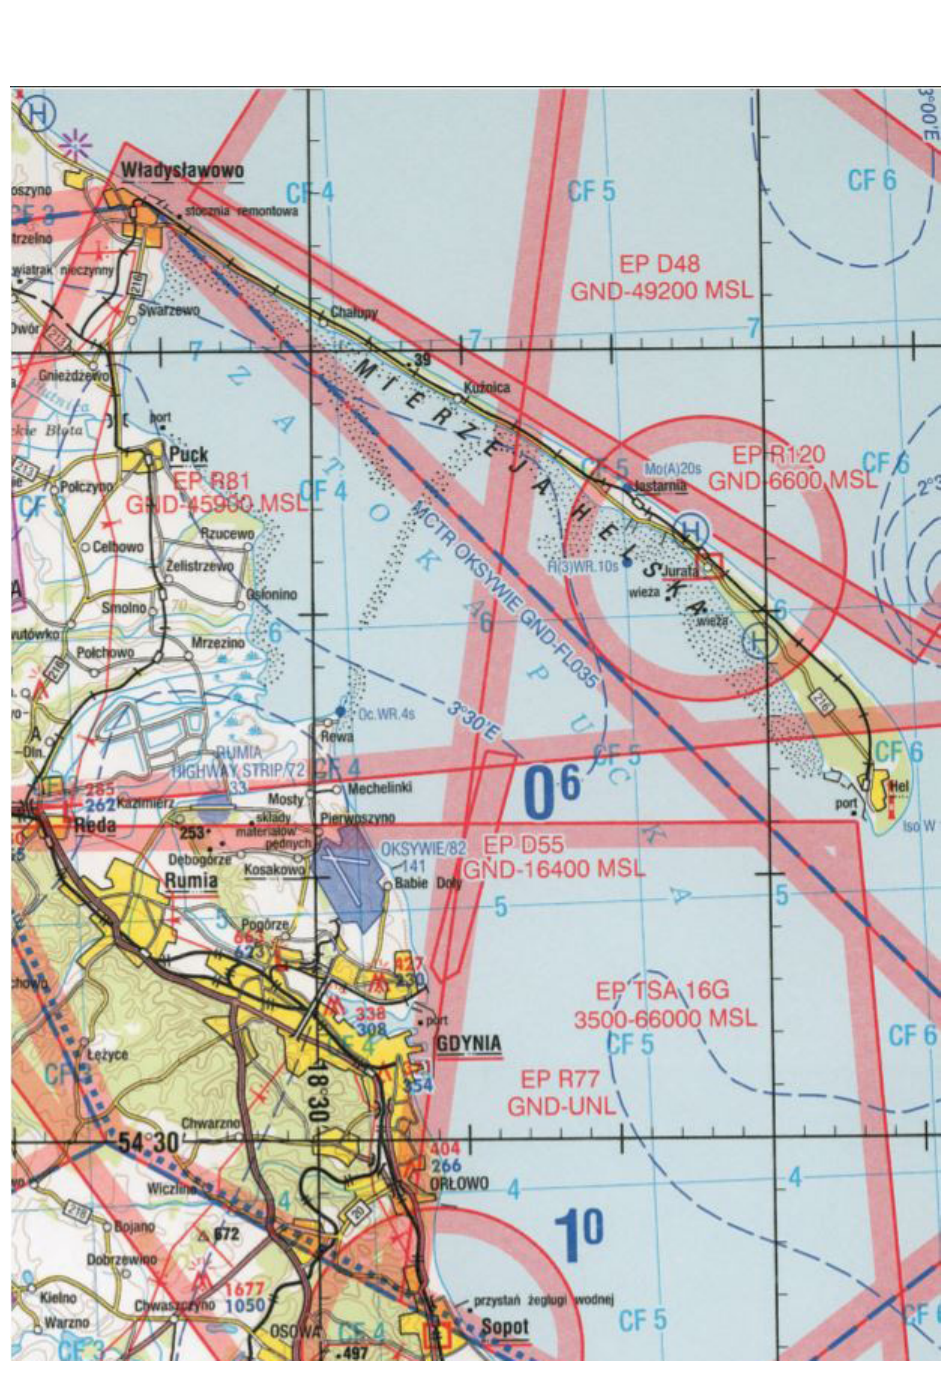
Fig. 16. Transit Flying Chart (Low Level) , 1:250,000 – TFC(L)